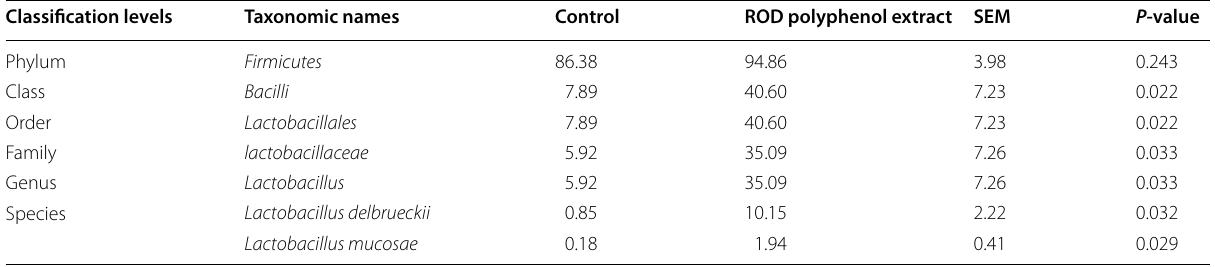
Table 4 Relative abundances of main different bacteria in ileal digesta at different taxonomic levels between control and ROD treatment group (%) Classification